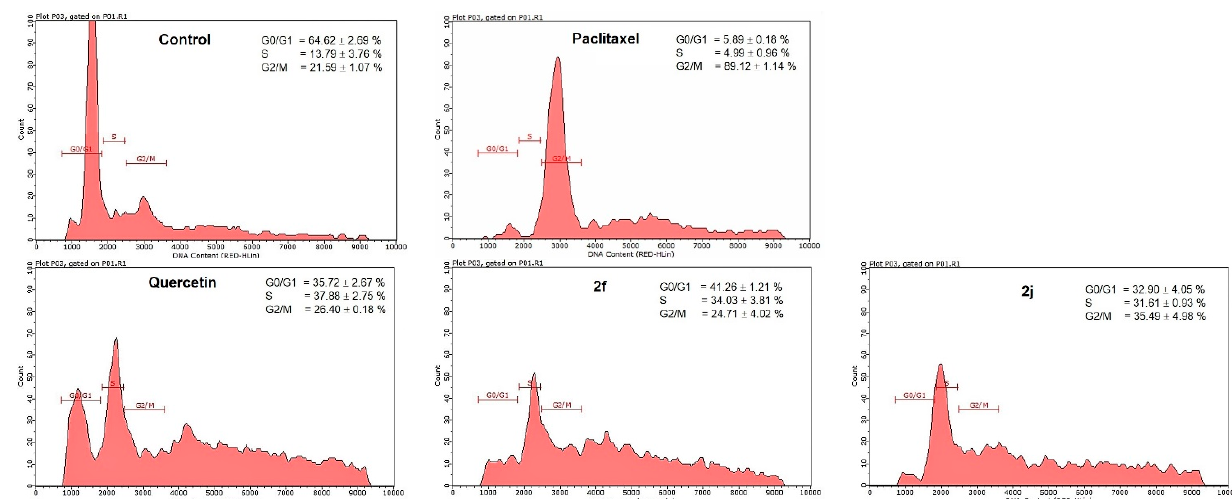
Figure 6. Flow cytometry analysis of cell cycle. Representative flow cytometry histograms of the percentage of cells in G0/G1, S, and G2/M phases of the cell cycle in HeLa cells. Cells treated with 2f , 2j , quercetin with concentration at IC 50 , paclitaxel (5 µM), or untreated control for 24 h. Control and treated cells were fixed, stained, and analyzed by flow cytometry as per the Muse ® cell cycle kit protocol.